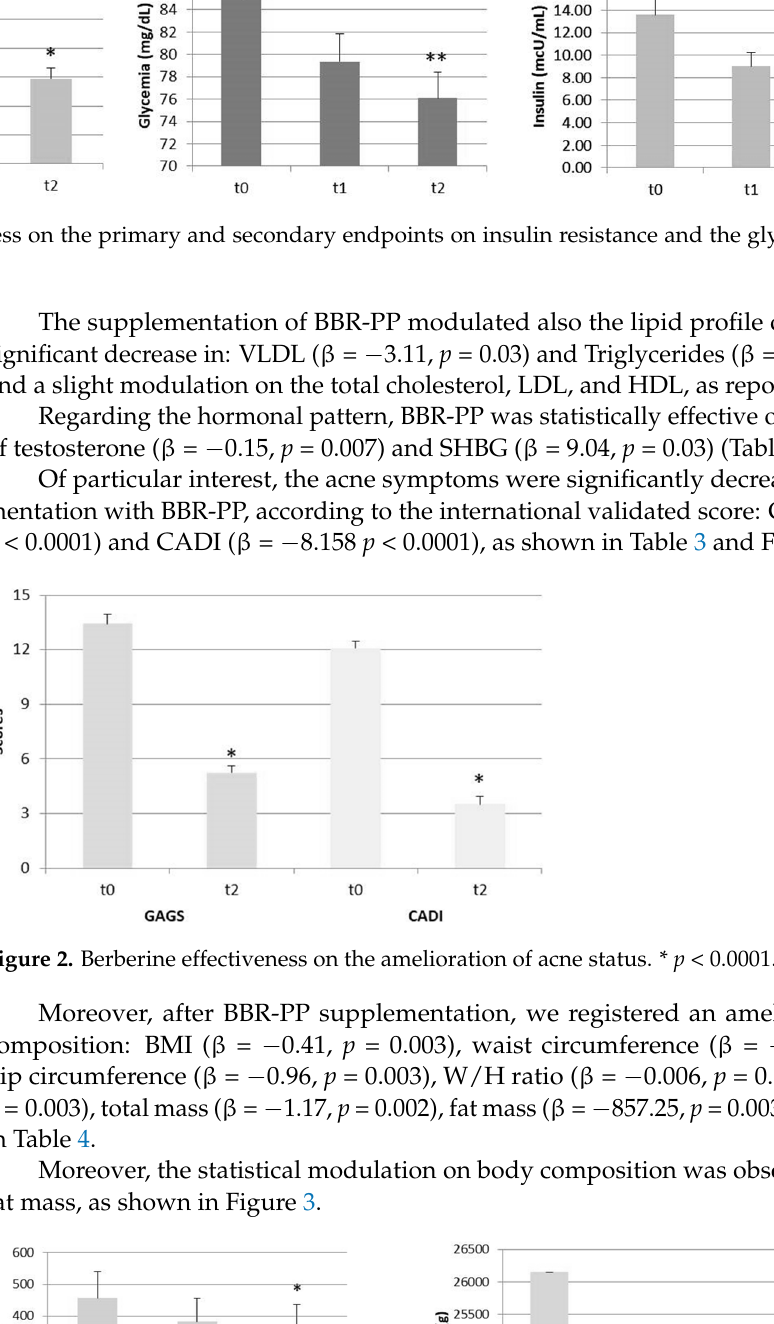
Figure 3. BBR-PP effectiveness on body composition, inducing a redistribution of adipose tissue with the reduction of the visceral fat tissue and fat mass. * p < 0.005.